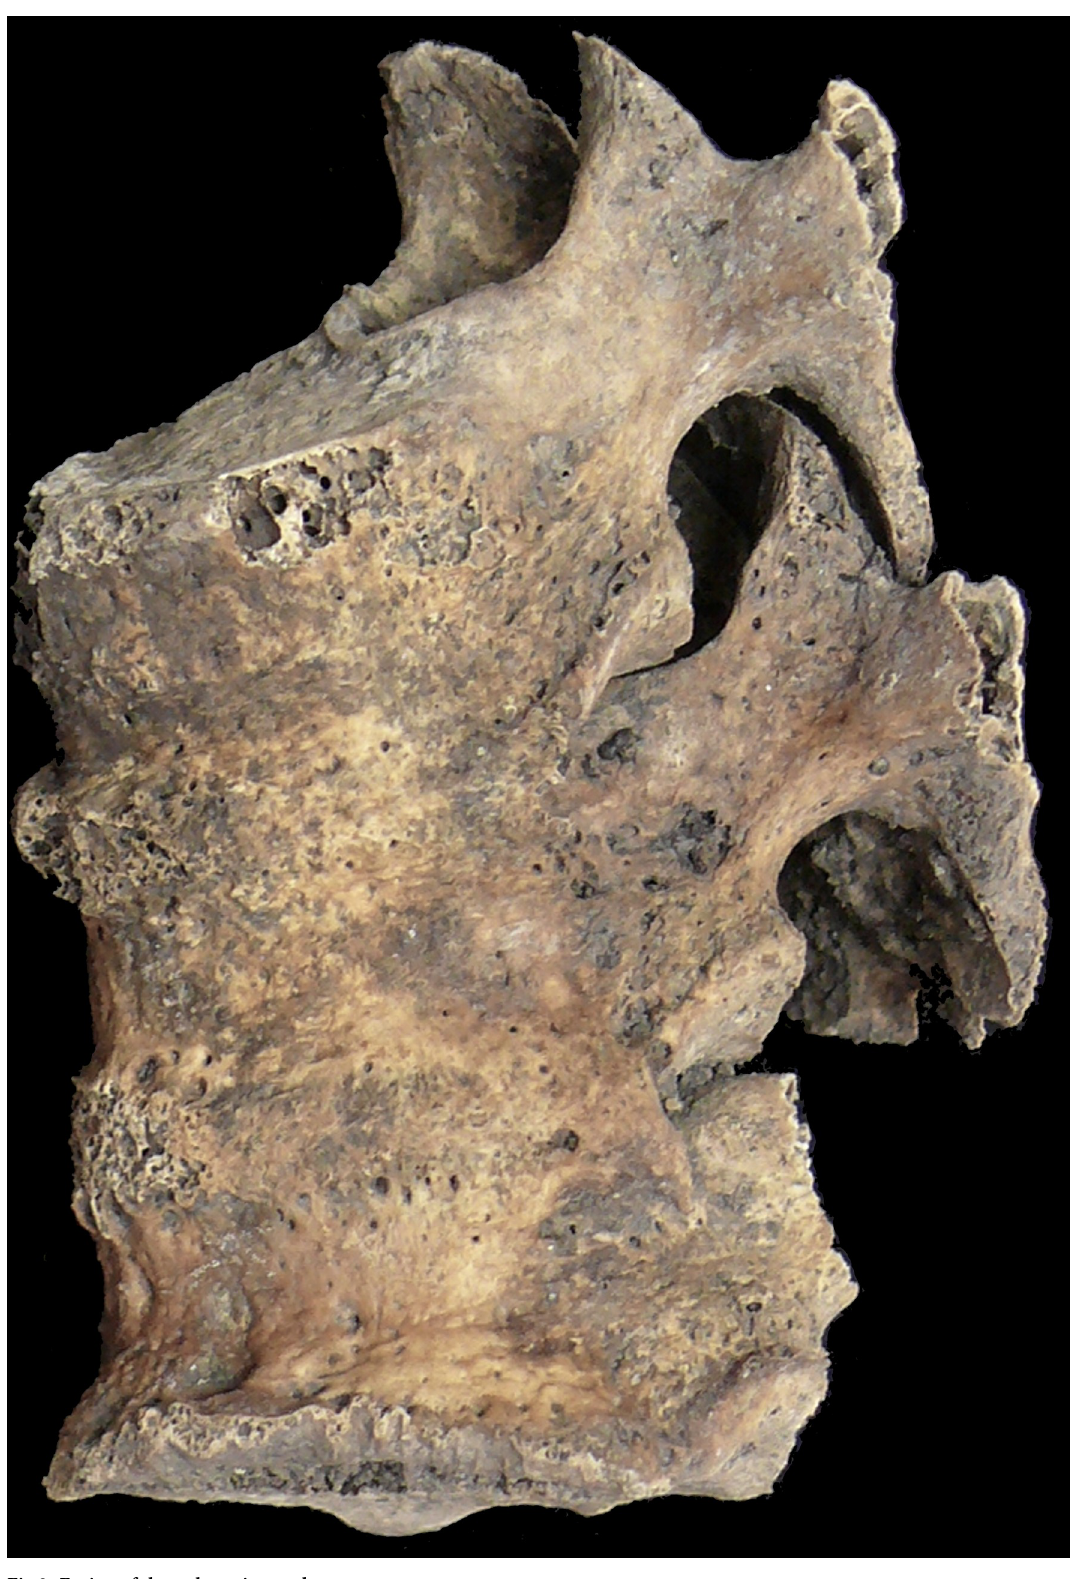
Fig 3. Fusion of three thoracic vertebrae.